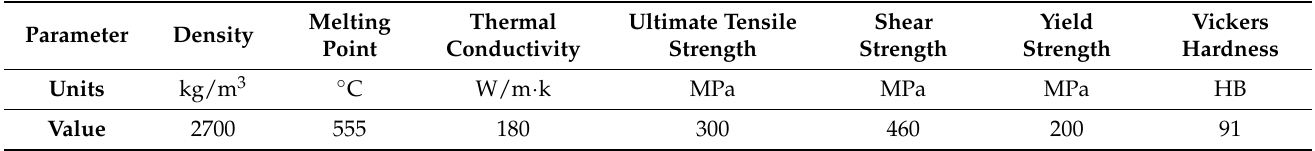
Table 1. Mechanical Properties of AA6068 aluminum alloy.